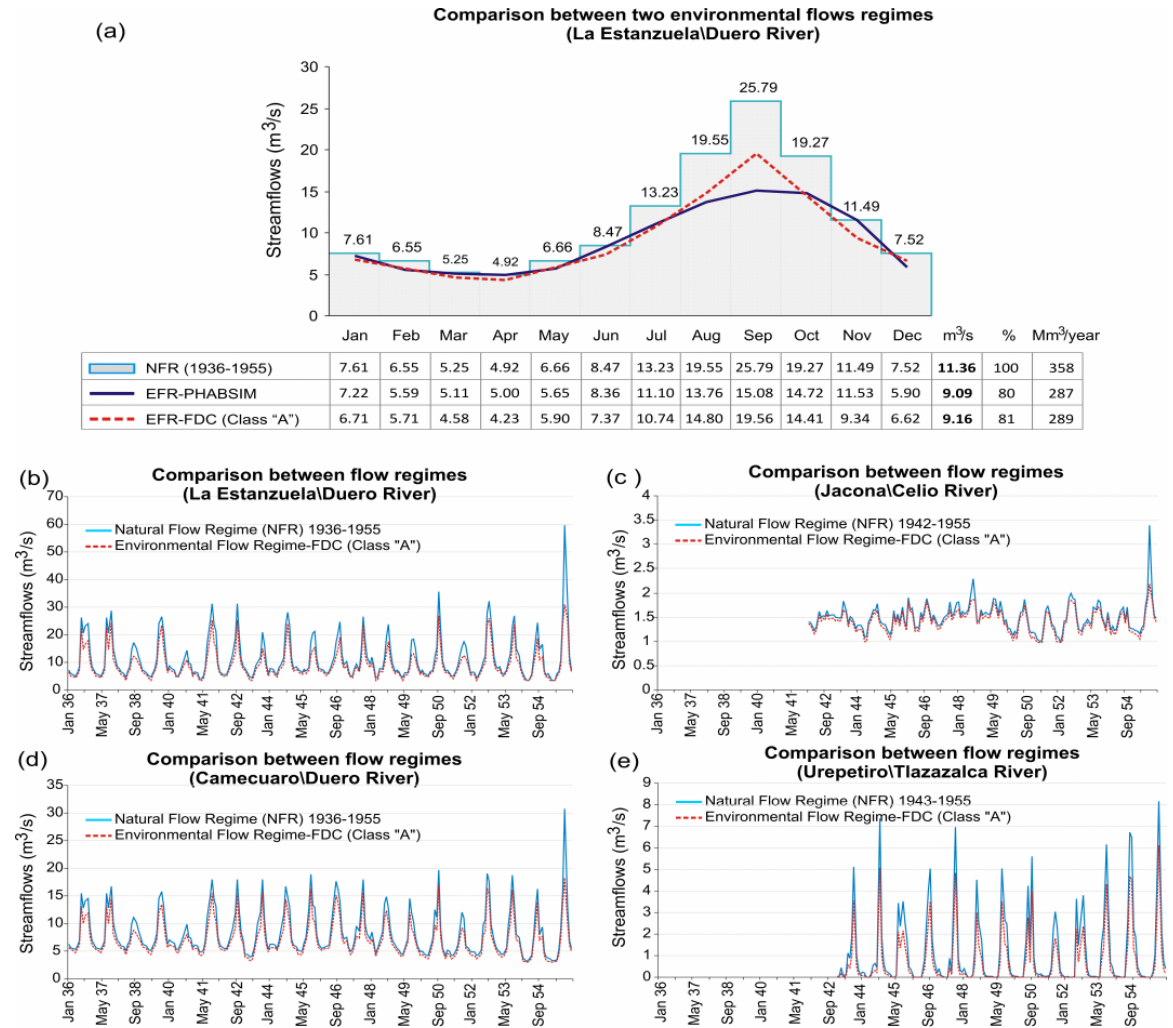
Figure 5. ( a ) Monthly comparison between the EFR proposed by PHABSIM and FDC of WEAP. ( b – e ) The annual comparison between the natural flow regimes and the environmental flows proposed by WEAP through the flow duration curve (FDC).